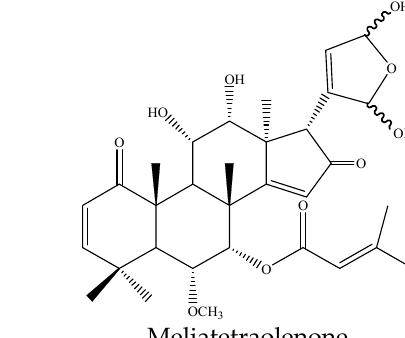
Figure 3. The structures of ring intact limonoids: azadirones.